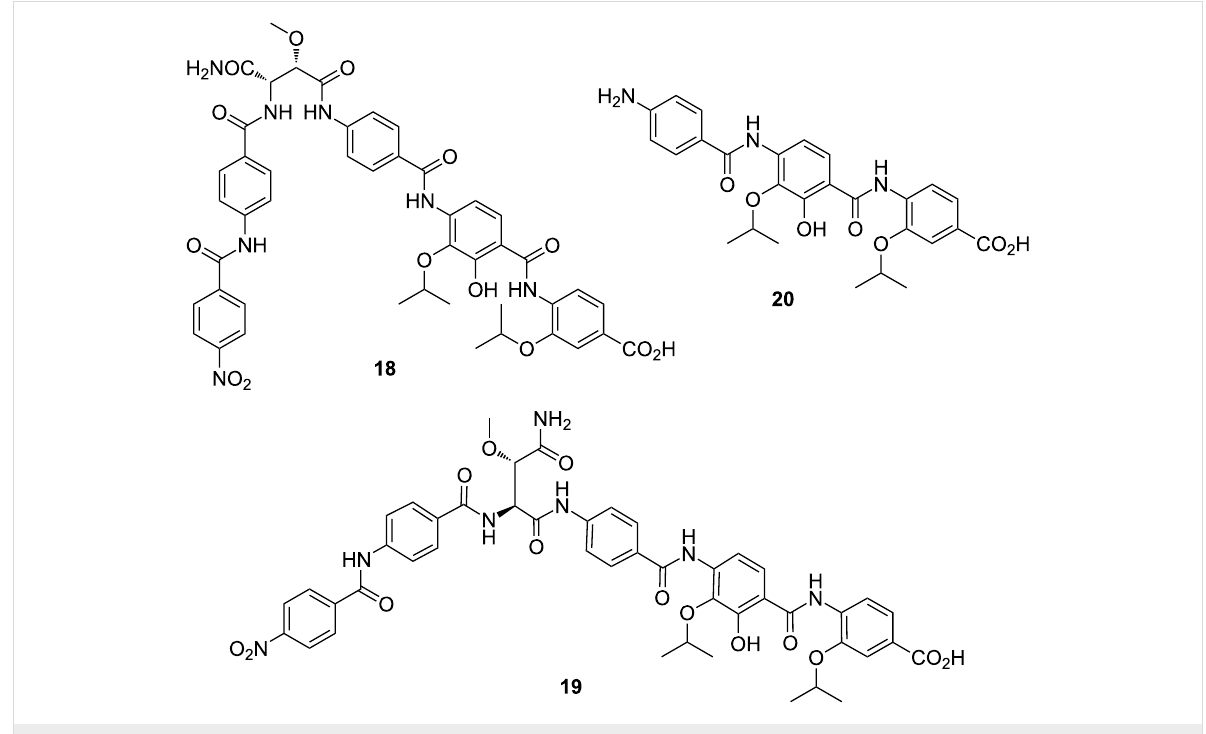
Figure 5: Structures of cystobactamids 919-1 ( 18 ), 919-2 ( 19 ), and 507 ( 20 ).